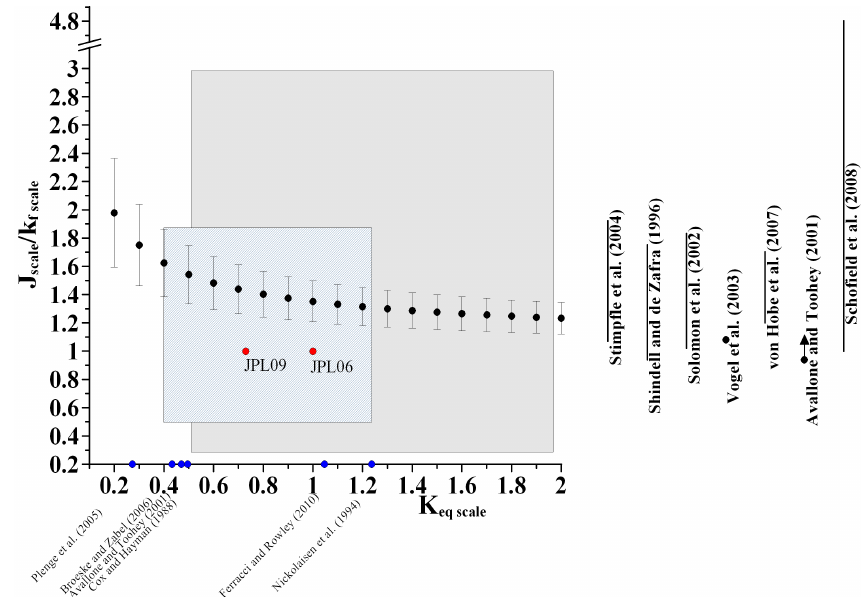
Fig. 2. The retrieved scale factors and 1 σ uncertainties for J/k f and K eq from all OE runs. Vertical bars along the y-Axis: Results from earlier studies for J scale /k f scale at 190K. Blue symbols along the X-axis: K eq scale relative to JPL06 determined from earlier studies (190 <T < 210K). Light grey area: JPL06 uncertainty range on K eq and J/k f . Smaller rectangular hatched area towards the bottom left: JPL09 uncertainty range on K eq and J/k f (for more details see text).